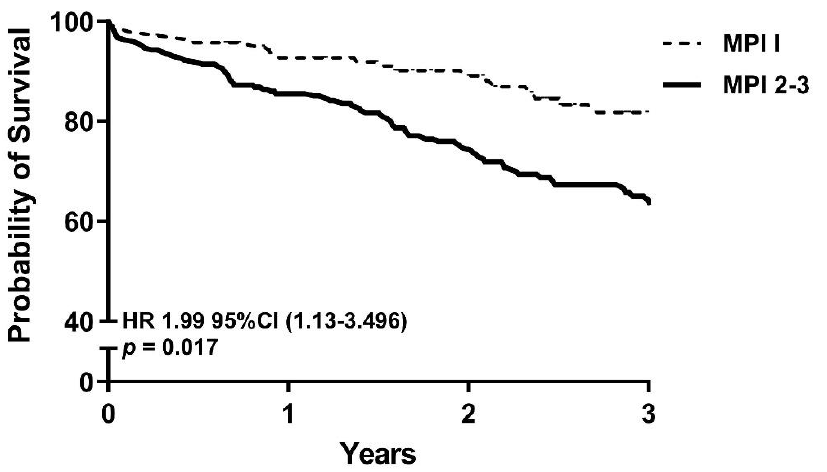
Figure 1. Cox regression survival curve stratified by MPI groups. Model adjusted for age, sex, diabetes mellitus, hypercholesterolemia, peripheral artery disease, renal dysfunction, limitation of mobility, logistic Euroscore, post-procedural stroke and delirium. Abbreviations used: MPI, Multiple Prognostic Index; HR, Hazard Ratio; CI, Confidence Interval.